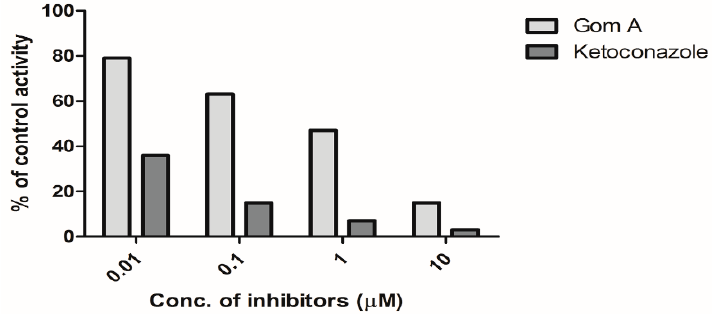
Figure 4. Inhibition of DCCTX production in HLMs by Gom A and Keto (0.01, 0.1, 1, and 10 µM) when incubated with CTX (100 ng/mL). HLMs (0.5 mg protein/mL) were preincubated with Gom A for 5 min in 100 mM PBS, the reaction was started by addition of NADPH-gs to the system. The mixture was incubated for 5 min at 37 °C. Each point represents the mean of triplicate determinations.